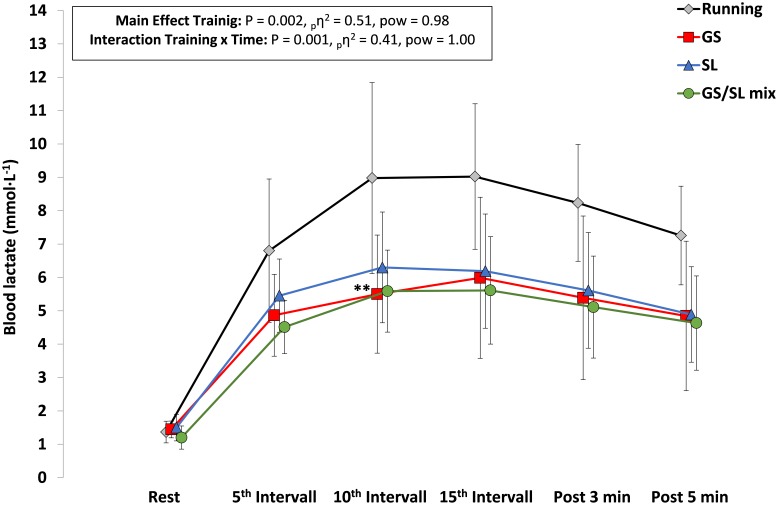
Blood lactate values after the 5th, 10th, and 15th interval and in the third and fifth minute post exercise for the four HIT protocols with running, giant slalom mode (GS), slalom mode (SL), and the mixed GS/SL mode. ∗∗P < 0.01; significant different to running; pη2, partial eta square effect size; pow, statistical power; and mean ± SD.